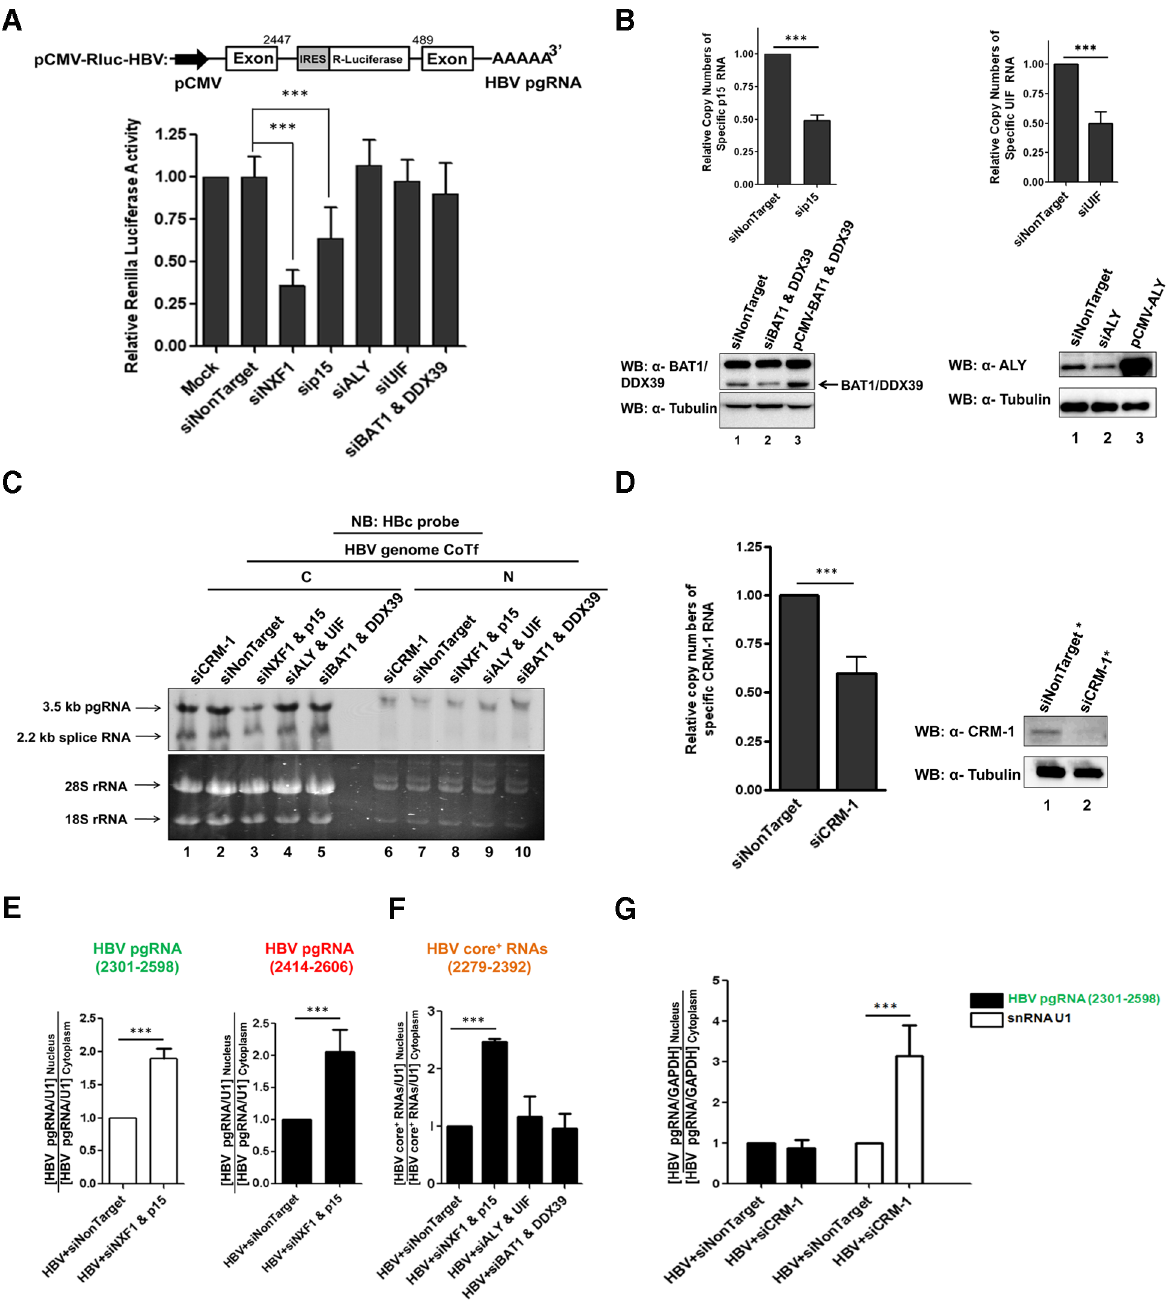
Figure 6. Both NXF1 and p15 can contribute to the efficient nuclear export of HBV pgRNA. A) Upper panel: A cartoon illustrates an HBV pgRNA reporter plasmid containing a Renilla luciferase gene inserted into a major intron of HBV pgRNA [25]. Lower panel: HuH-7 cells were co- transfected with an HBV pgRNA reporter plasmid and siRNAs. Reduction of the luciferase reporter activity was observed by treatment with siRNAs specific for NXF1-p15, but not with siRNAs specific for TREX components. To control for the indirect effect of siRNA knockdown (Material and Methods), Renilla luciferase activity was normalized with a co-transfected internal reference plasmid (firefly luciferase reporter). The relative Renilla luciferase activity of mock transfection was presented as 1. The graph here represents an average from at least three independent experiments. B) Upper panel : The knockdown efficacies of siRNAs specific for p15 and UIF were measured by RT-qPCR analysis, respectively. The copy number of RNA from siNonTarget treatment was presented as 1. Lower panel: Similarly, the efficacies of siRNAs specific for BAT1/DDX39 (lane 2, left panel ) and ALY (lane 2, right panel ) were measured by Western blot analysis, respectively. Expression vectors pCMV-BAT1, pCMV-DDX39 (lane 3, left panel ), and pCMV-ALY (lane 3, right panel ), were shown to produce their respective protein products by Western blot analysis. C) Only the siRNAs specific for NXF1 and p15 reduced the cytoplasmic core + RNA levels by Northern blot (NB) analysis using an HBc specific probe (Fig. 1). Only weak signals of pgRNA were detected in the nuclear fraction. The faint signals of 45S, 32S and 20S ribosomal RNA precursors in the nuclear fraction can be seen after longer exposure [17]. D) The knockdown efficacy of siRNAs specific for CRM-1 was measured by RT-qPCR (left panel) and Western blot analyses (right panel). The copy number of RNA from siNonTarget treatment was shown as 1. *Transfected cells in the Western blot experiment were enriched by puromycin selection. The relative distribution of pgRNA ( E ) and HBV core + RNAs ( F ) between the nuclear and cytoplasmic compartments was